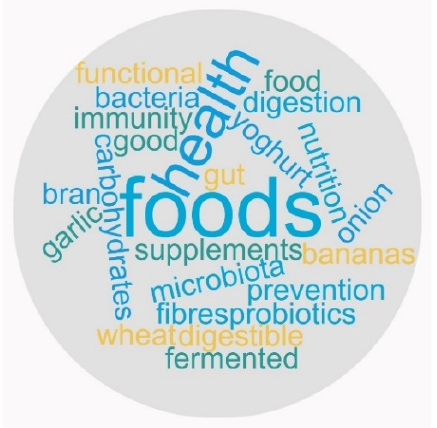
Figure 8. Terms associated with the concept of “prebiotics” by survey responders.